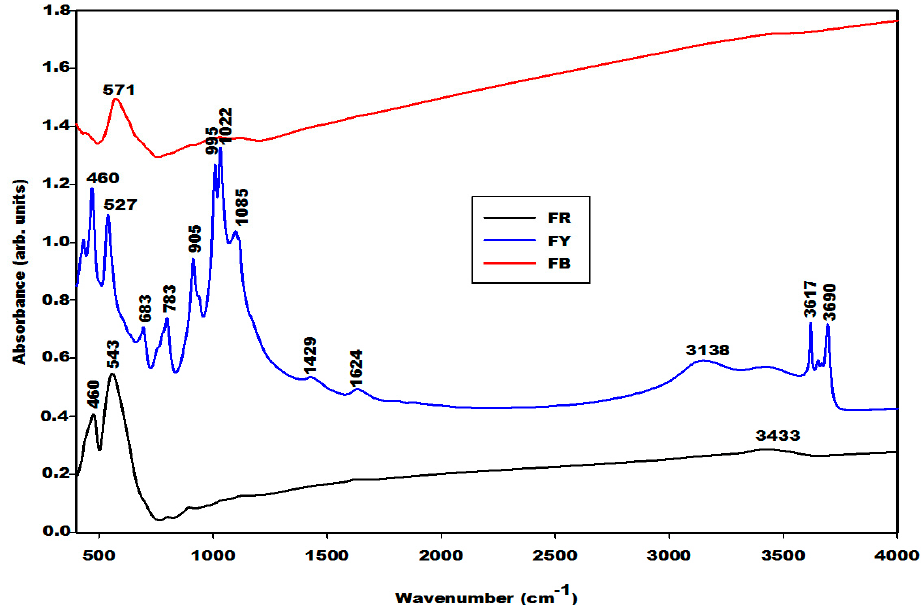
Figure 3. Infrared spectra of different iron oxide samples (FR, FB and FY).